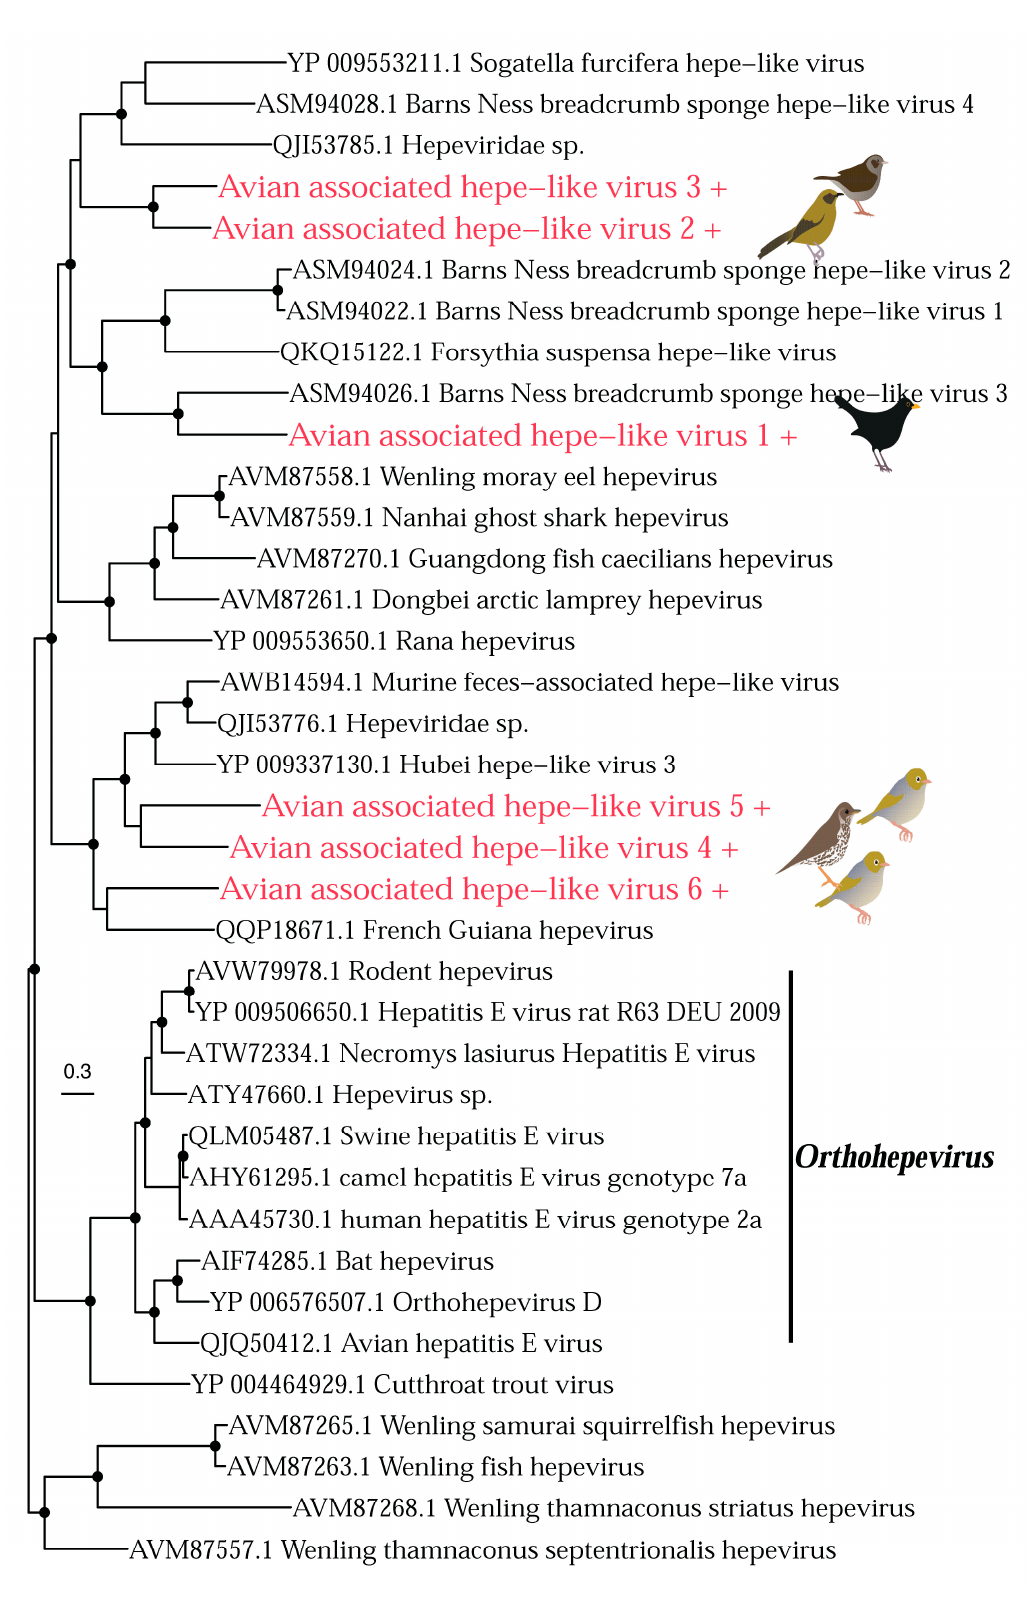
Figure 9. Phylogeny of the Hepeviridae based on the non-structural polyprotein (alignment length of 840 amino acids). Colours and symbols as shown in Figure